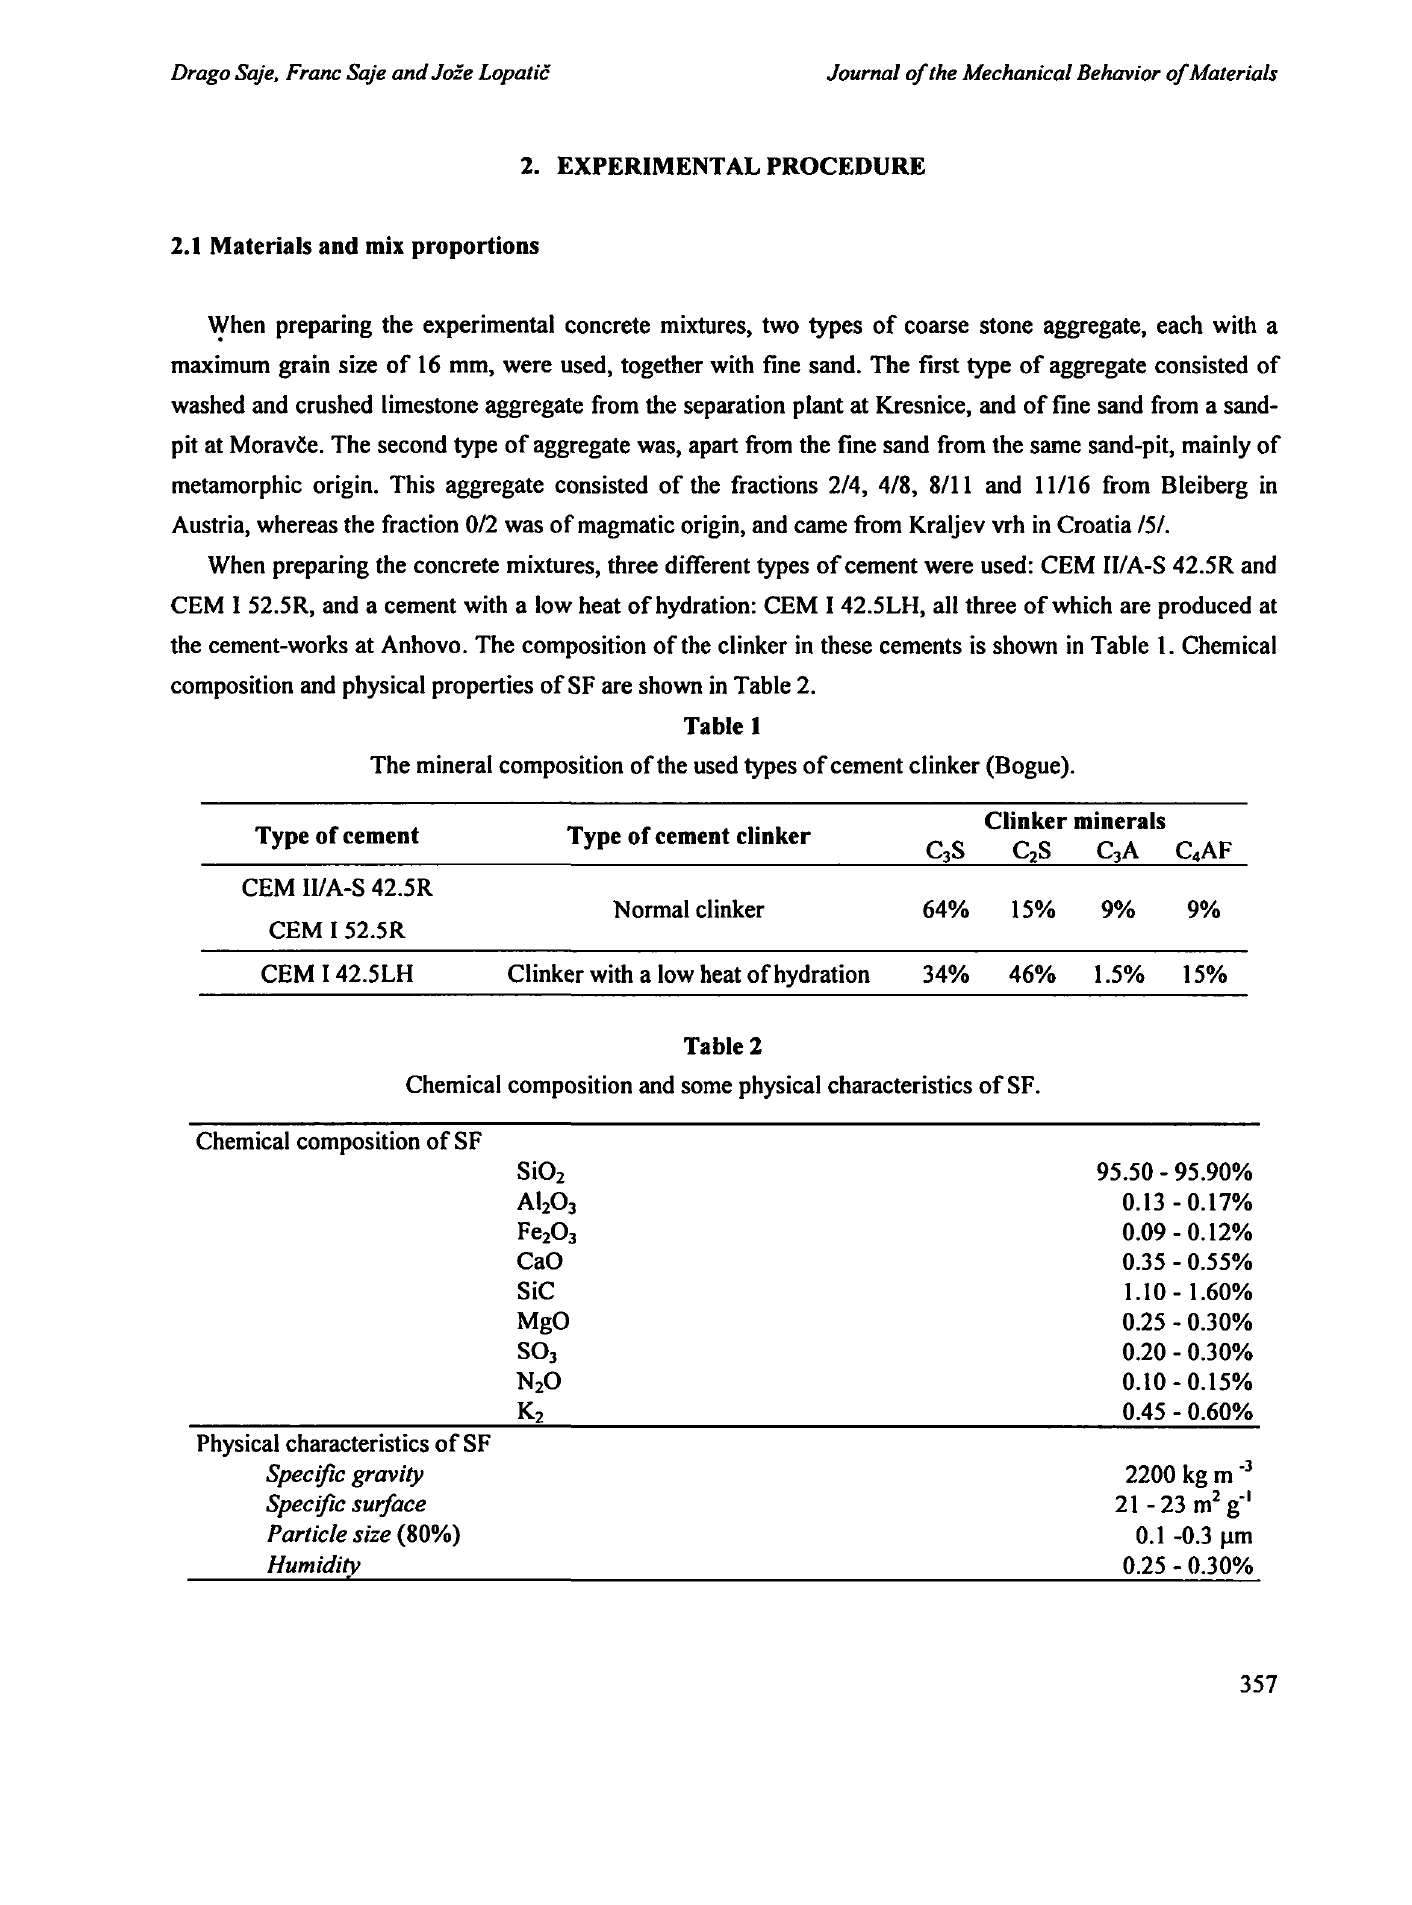
Chemical composition and some physical characteristics of